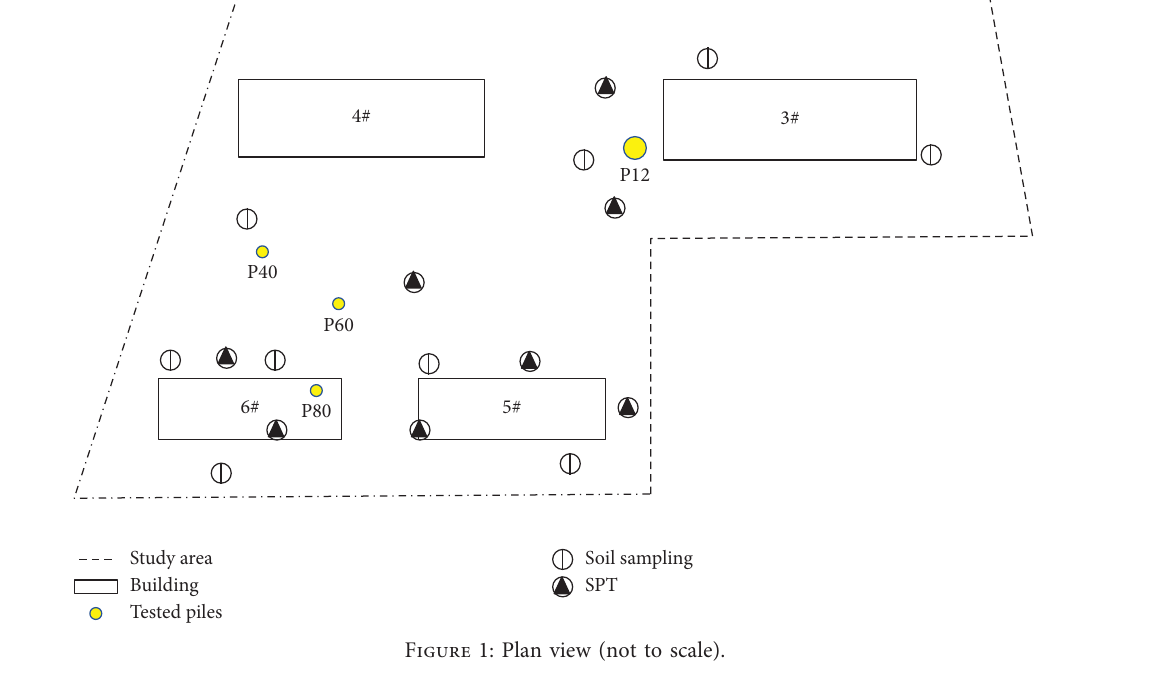
Figure 1: Plan view (not to scale).